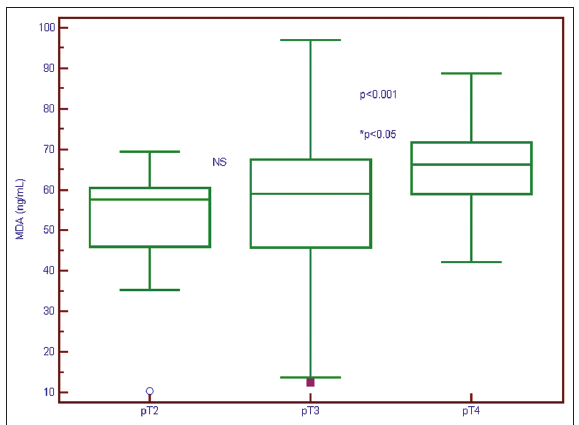
FIGURE 2. Serum malondialdehyde concentration in CRC patients with different depth of tumor invasion. The data are presented as median, with minimum–maximum values. p <0.001 - significance difference between pT3 and pT4, * p <0.05 - significance difference between pT2 and pT4, NS: No significance between pT2 and pT3. CRC: Colorectal cancer, MDA: Malondialdehyde, pT: Depth of tumor invasion.